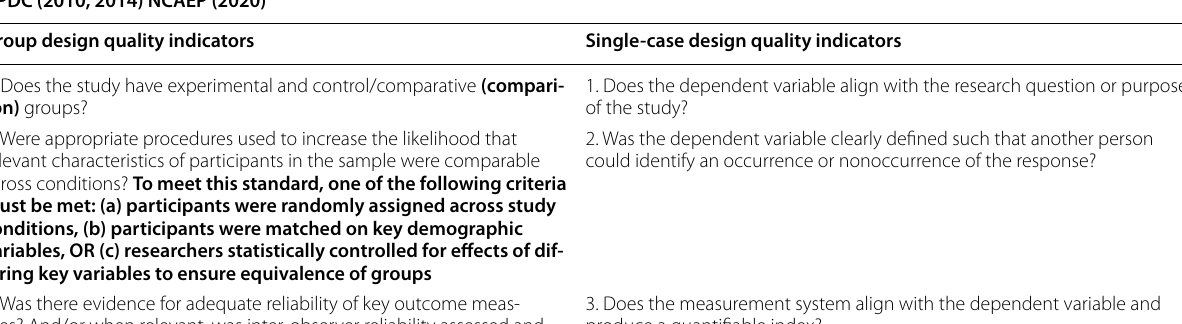
Table 7 Classification of evidence assessment items used by NPDC/NCAEP for studies with group and single-subject designs